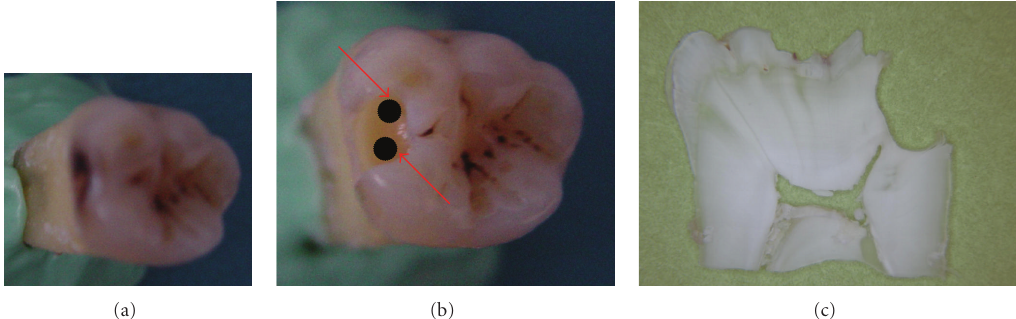
Figure 2: (a) D3 caries: (b) After caries dentin was mechanically removed, to ensure that the same spots were analyzed each time, two signs were done on photographs with a black pen (c) histological